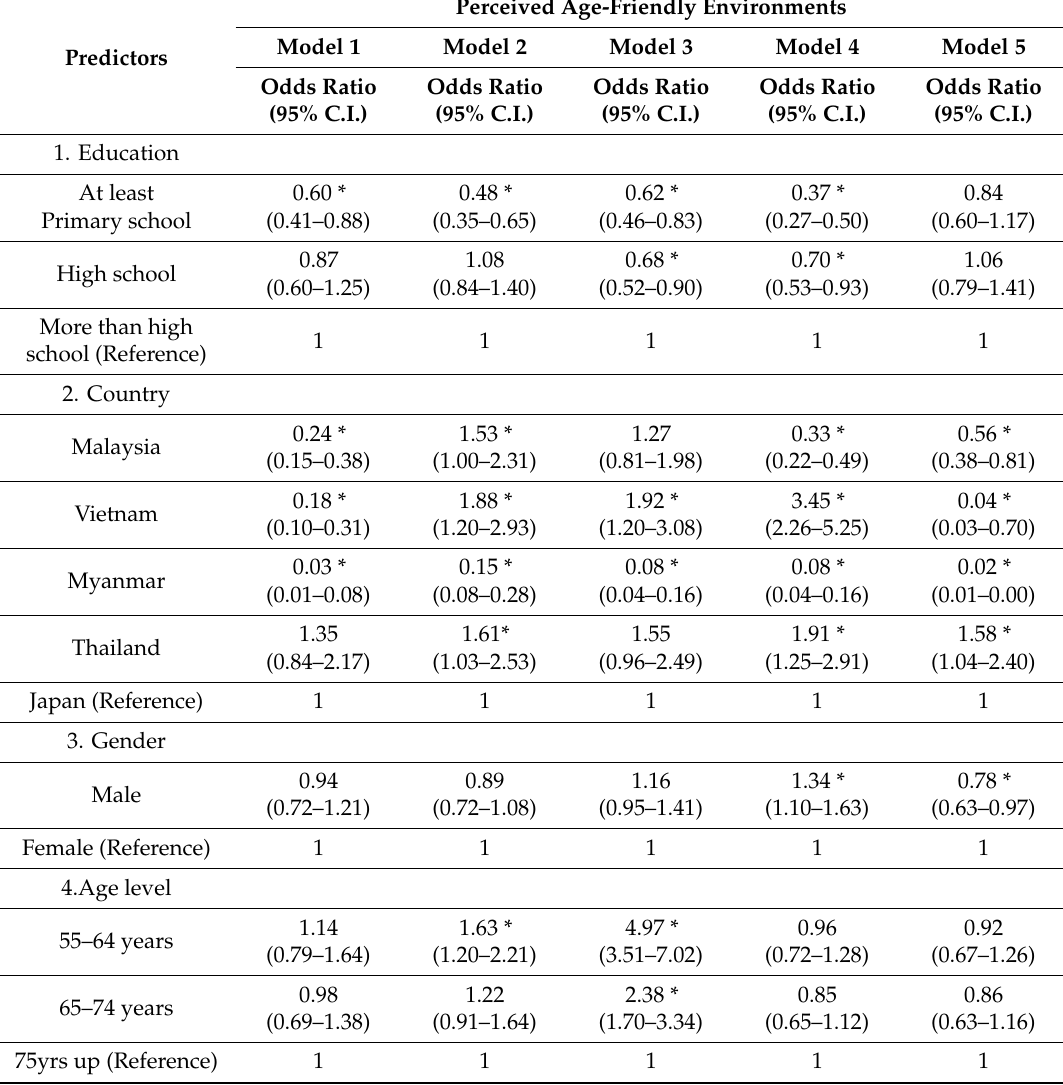
Table 4. Predictors of perceived “bad” age-friendly environments, analyzed by ordinal logistic regression with five perceived age-friendly environments as a three ordinal outcome scale (bad, fair, and good) and four predictors (educational level, gender, age level, and country of